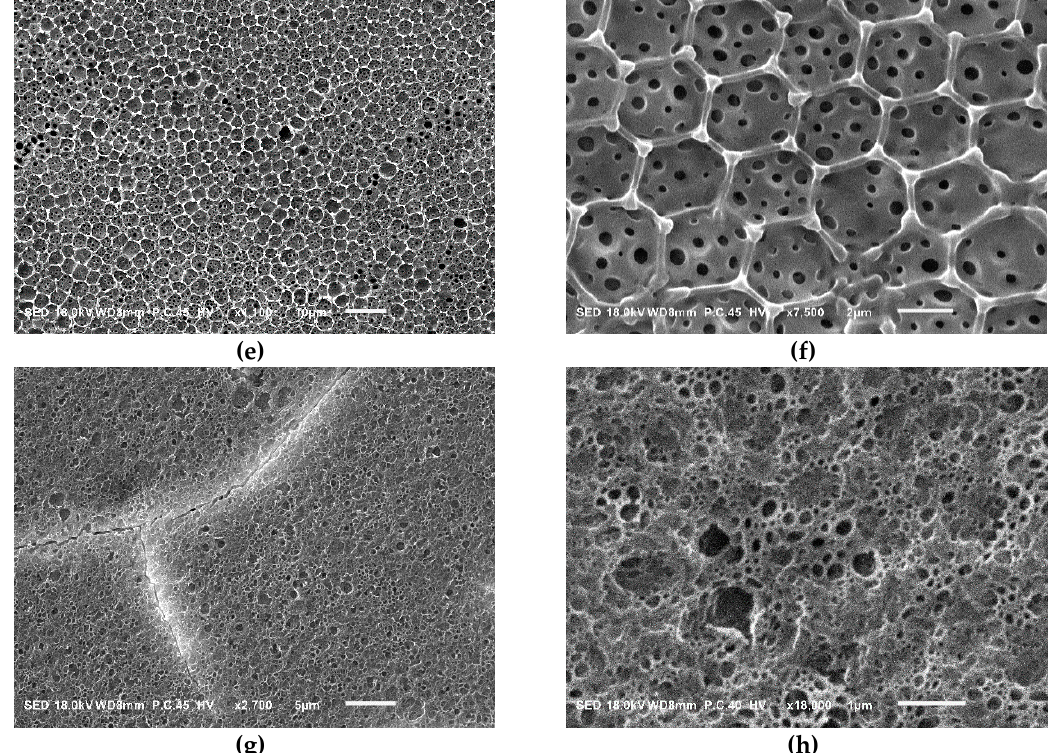
Figure 3. SEM images of BF films prepared from first generation LDBCs with acetonide end groups: ( a , b ) LG1-PSt 11k; ( c , d ) LG1-PSt 8.5k . ( e , f ) LG1-PSt 4.9k, edge of the film; ( g , h ) LG1-PSt 3.5k. Scale bars: ( a ) 20 μ m; ( c , e ) 10 μ m; ( g ) 5 μ m, ( f ) 2 μ m; ( b , d , h ) 1 μ m.